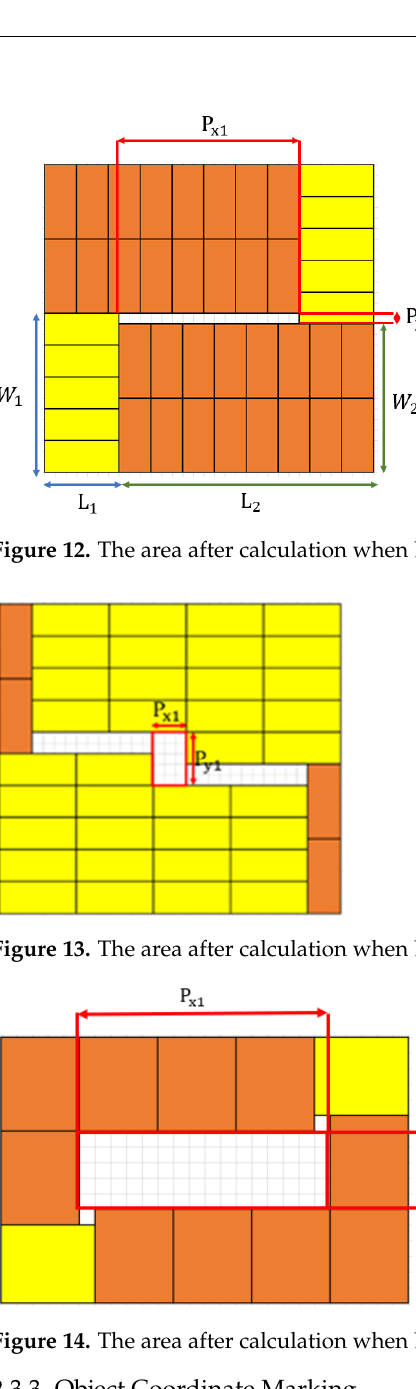
Figure 12. The area after calculation when Block 2 and Block 4 are non-overlapped.